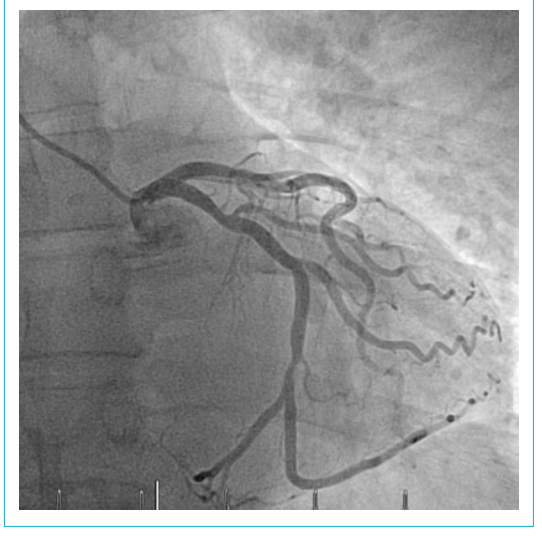
Figure 2a: Intra-arterial coronary angiogram showing a high-grade stenosis of the circumflex branch of the left coronary artery prior to drug eluting stent placement.